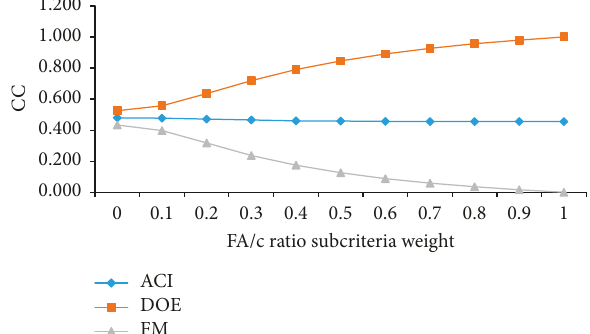
Figure 7: Sensitivity analysis of mix design methods with respect to FA/T weight.